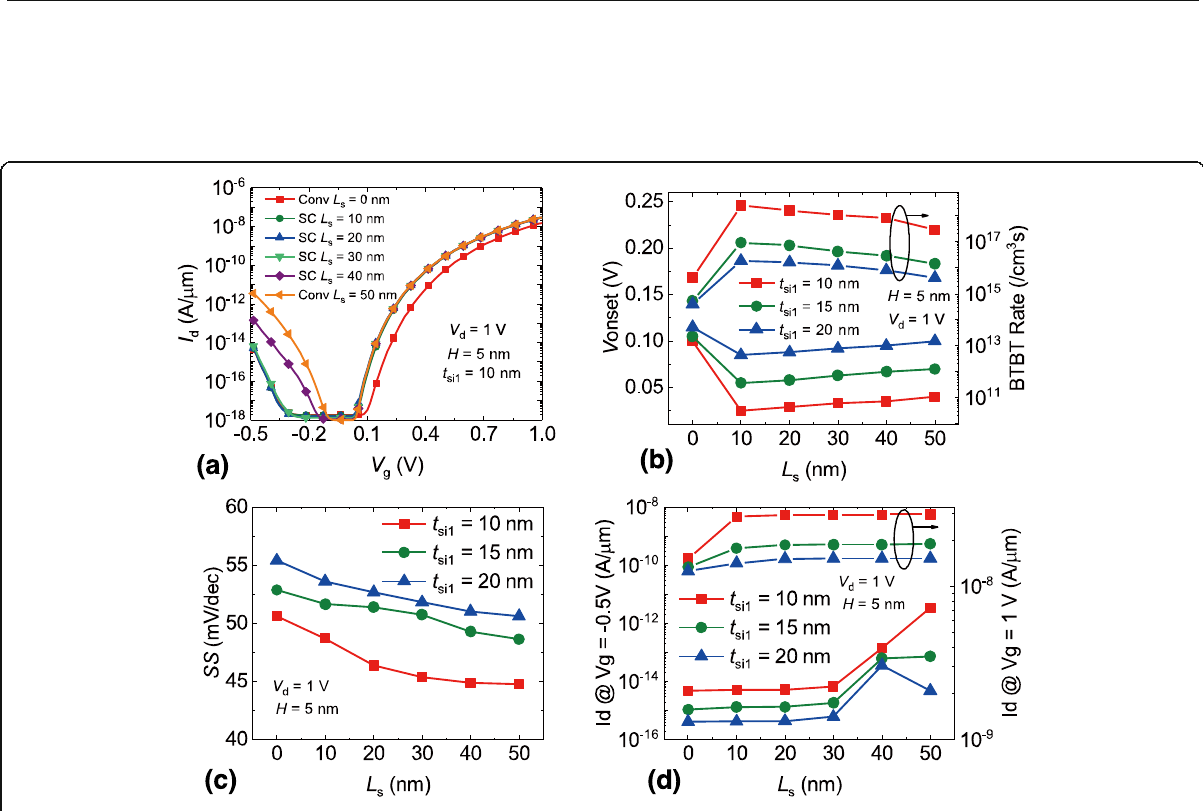
Fig. 6 The impacts of L s on the a transfer curves, b V onset and BTBT rate, c average SS , and d drain current in on/ambipolar state, L s is the lateral distance from the source region to the step, L s = 0 nm represents the conventional DG TFET with corresponding t si2 and L s = 50 nm represents the conventional DG TFET with corresponding t